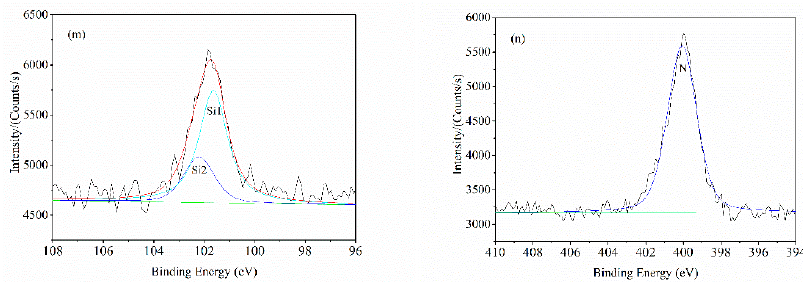
Figure 10. Peak di ff erentiating curves of PLA / BF composites: ( a ) PLA-C1s; ( b ) PLA-O1s; ( c ) Figure 10. Peak differentiating curves of PLA/BF composites: ( a ) PLA-C1s; ( b ) PLA-O1s; ( c ) PLA/UBF- PLA / UBF-C1s; ( d ) PLA / UBF-O1s; ( e ) PLA / ABF-C1s; ( f ) PLA / ABF-O1s; ( g ) PLA / SBF-C1s; ( h ) C1s; ( d ) PLA/UBF-O1s; ( e ) PLA/ABF-C1s; ( f ) PLA/ABF-O1s; ( g ) PLA/SBF-C1s; ( h ) PLA/SBF-O1s; ( i ) PLA / SBF-O1s; ( i ) PLA / SBF-Si2p; ( j ) PLA / SBF-N1s; ( k ) PLA / ASBF-C1s; ( l ) PLA / ASBF-O1s; ( m ) PLA/SBF-Si2p; ( j ) PLA/SBF-N1 s ; ( k ) PLA/ASBF-C1s; ( l ) PLA/ASBF-O1s; ( m ) PLA/ASBF-Si2p; ( n ) PLA / ASBF-Si2p; ( n ) PLA / PLA/ASBF-N1 s .